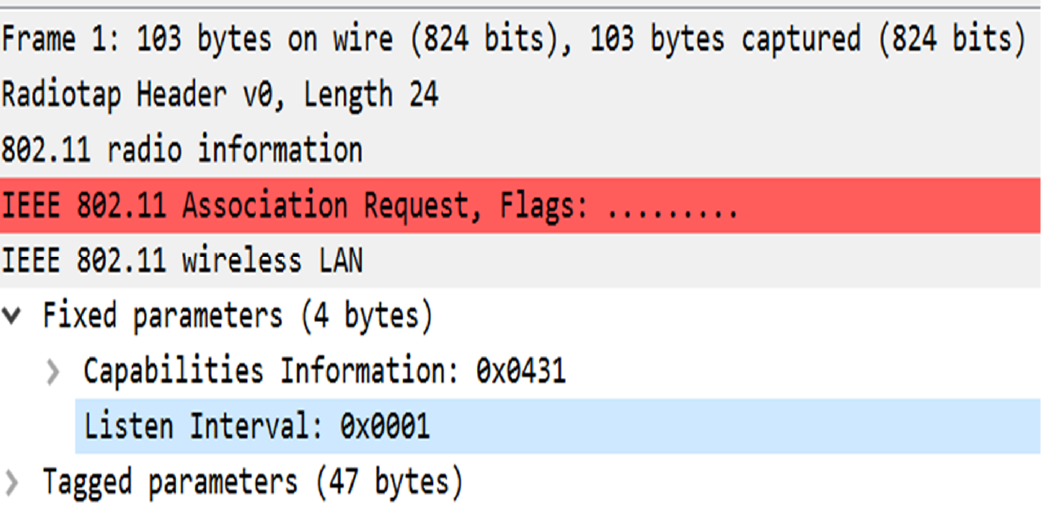
Figure 1. Power management transition.